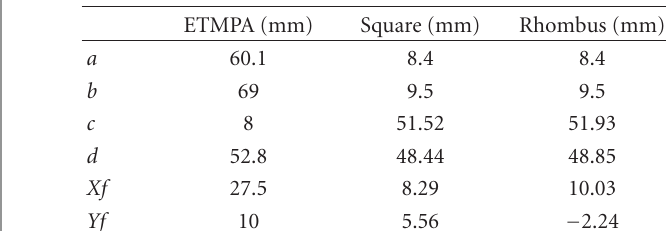
Figure 4: Rhomboidal ring patch antenna. Table 1: Patch dimensions of the three antenna element topologies on Azzurri foam, used in the simulation